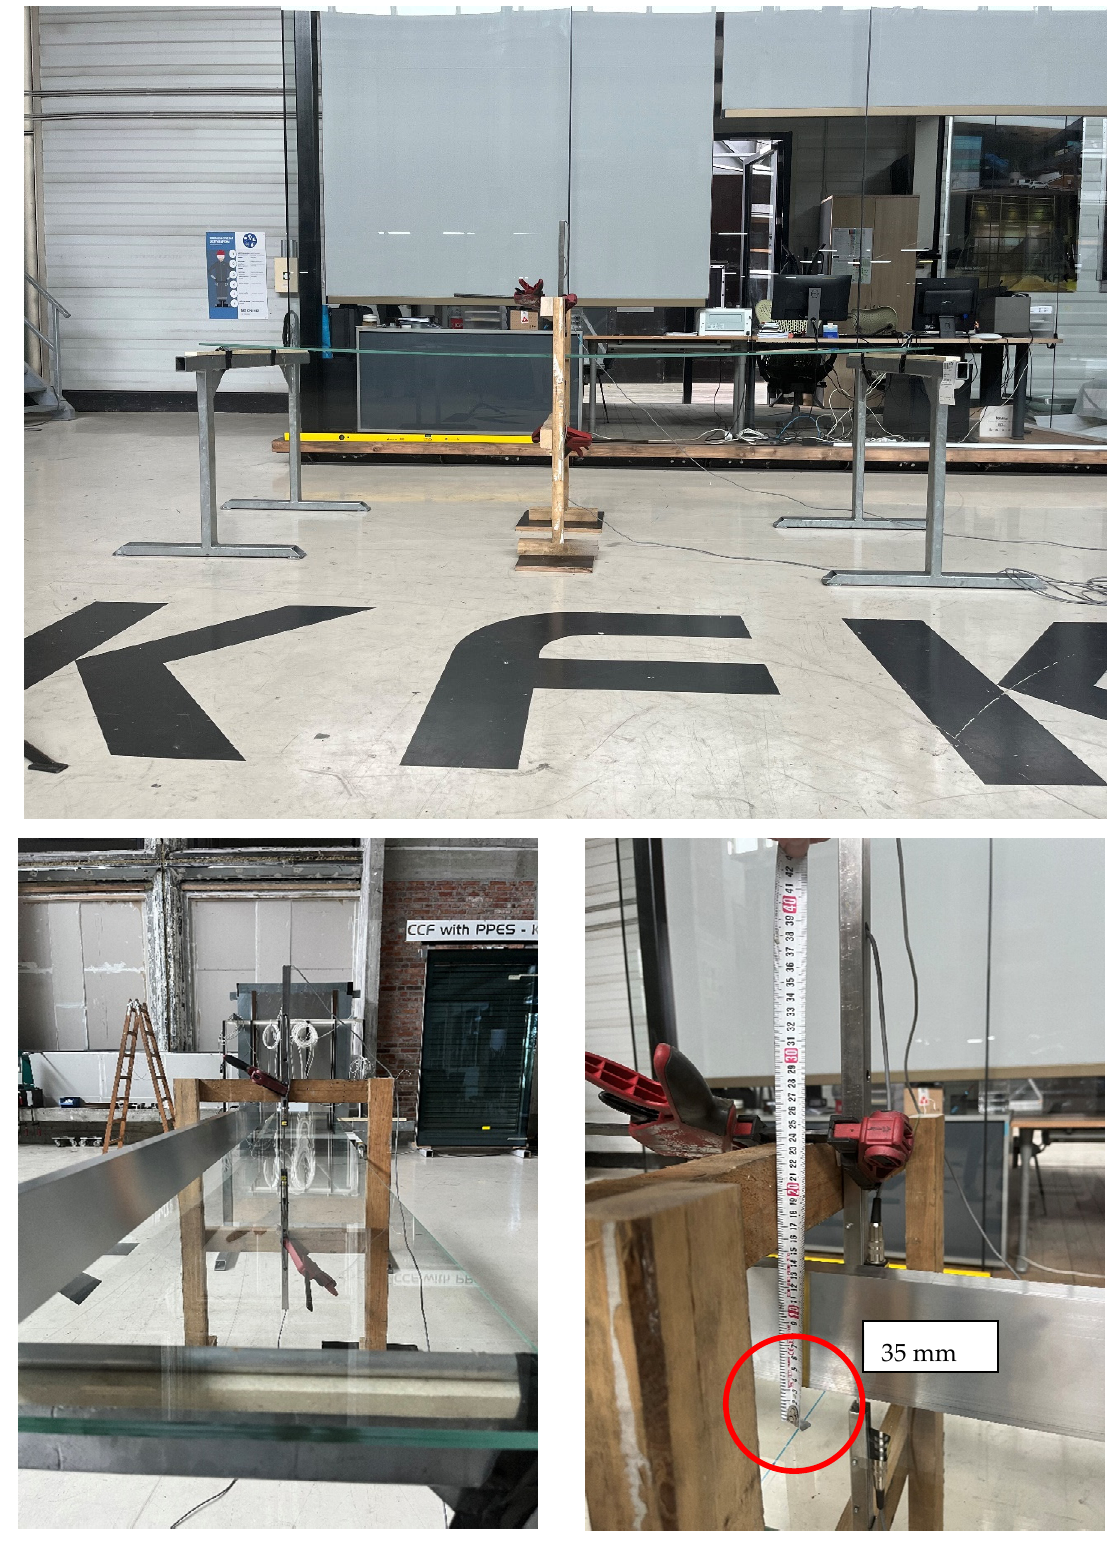
Figure 7. Displacement measurement of laminated glass in KFK d.o.o. (Zagreb, Croatia).